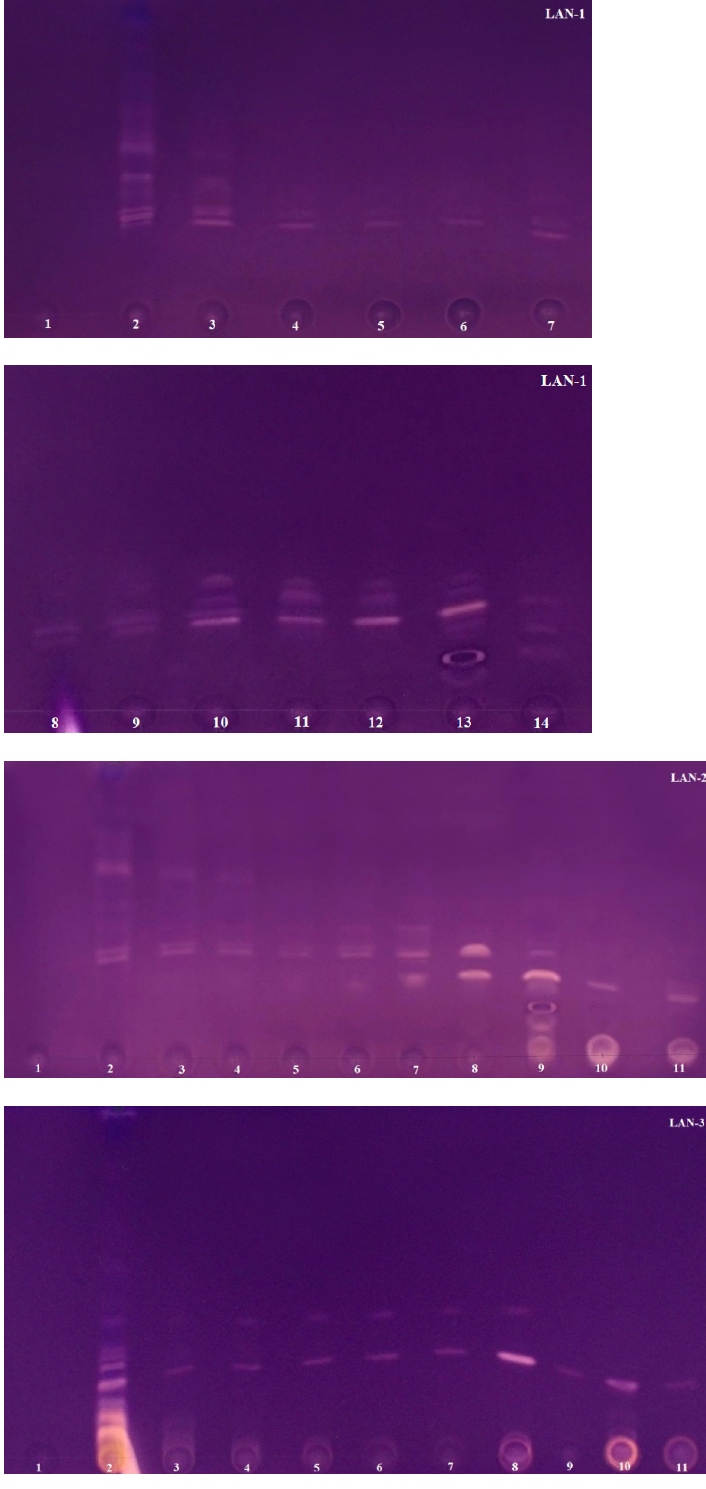
Figure 3. TLC chromatograms presenting L. annotinum fractions obtained from three experiments after acetylcholinesterase assays. LAN ‐ 1 shows 14 fractions obtained from the first experiment via VLC using Al 2 O 3 and silica gel in ratio 1:3 as sorbents; LAN ‐ 2 shows 11 fractions obtained from the second experiment via VLC using Al 2 O 3 and silica gel in ratio 3:1 as sorbents; LAN ‐ 3 shows 11 fractions obtained from the third experiment via VLC using silanized silica gel as sorbent.